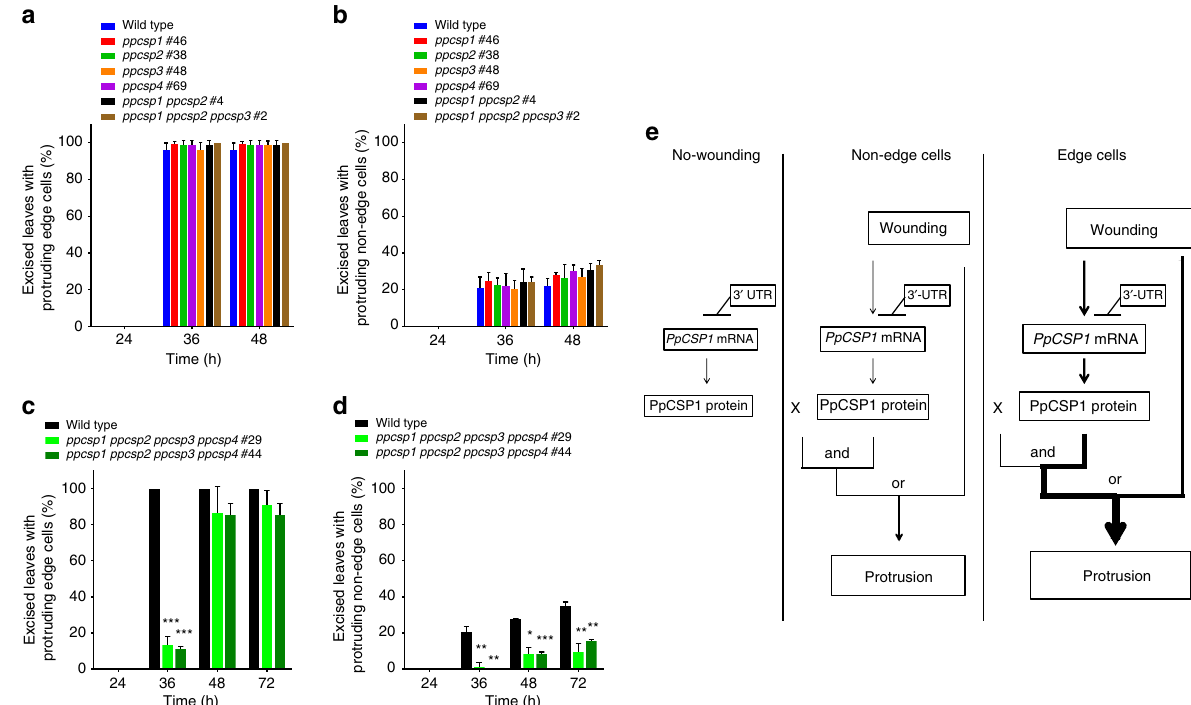
Figure 5 | Inhibition of reprogramming in quadruple deletion mutants. ( a , b ) Percentage of excised leaves with protruding edge cells ( a ) and protruding non-edge cells ( b ) in wild type, ppcsp1 #46, ppcsp2 #38, ppcsp3 #48, ppcsp4 #69, ppcsp1 ppcsp2 #4 and ppcsp1 ppcsp2 ppcsp3 #2. Twenty leaves were excised from each line. Error bars represent s.d. of biological triplicates. ( c , d ) Percentage of excised leaves of wild-type and ppcsp1 ppcsp2 ppcsp3 ppcsp4 (#29 and #44) with tip growth from edge ( c ) and non-edge cells ( d ), respectively. Twenty leaves were excised from each line. Error bars represent s.d. of biological triplicates. * P o 0.05, ** P o 0.01 and *** P o 0.001 by two-sided Welch’s t -test. ( e ) Hypothetical model of the function of PpCSP1 in the reprogramming. The 3 0 -UTR represses PpCSP1 expression in both edge and non-edge cells. Signals from wounding are capable of overriding the repression and of effectively increasing PpCSP1 expression, resulting in activation of the reprogramming